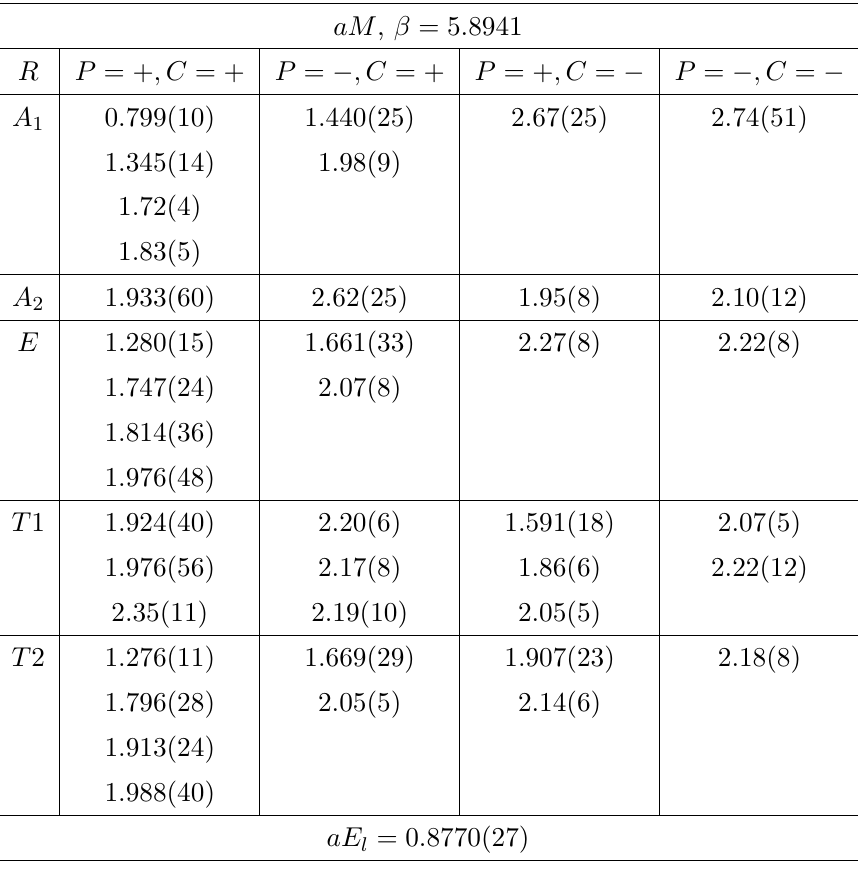
Table 8 . Glueball masses at β = 5 . 8941 on a 14 3 16 lattice for all octahedral representations, R , and for both values of parity, P , and charge conjugation, C . Also the energy E l of a winding flux